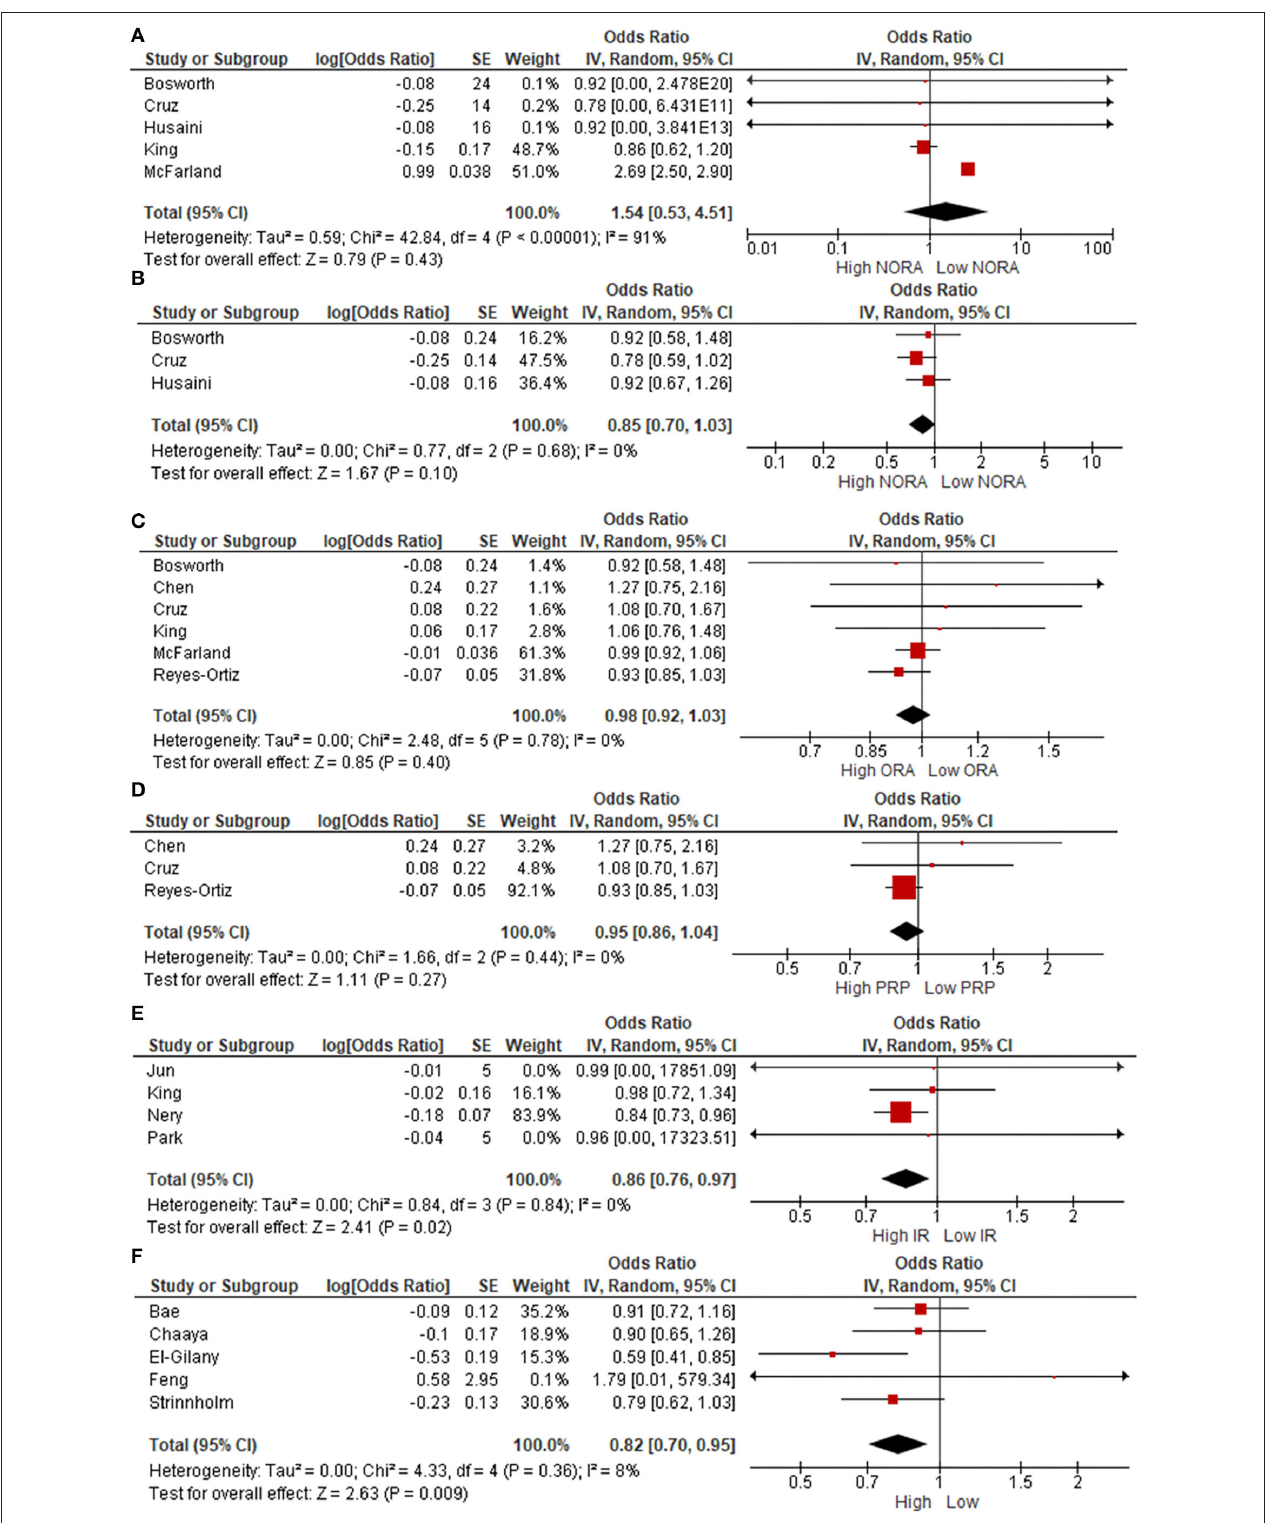
FIGURE 5 | Odds Ratio (OR) for (A) NORA, (B) service attendance, (C) ORA, (D) private religious practices (PRP), (E) intrinsic religiosity, and (F) religious affiliation.